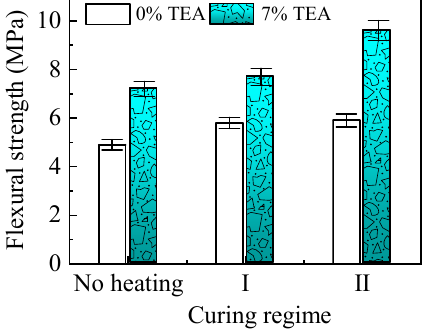
Figure 5. Flexural strength of CAM at different curing regimes.